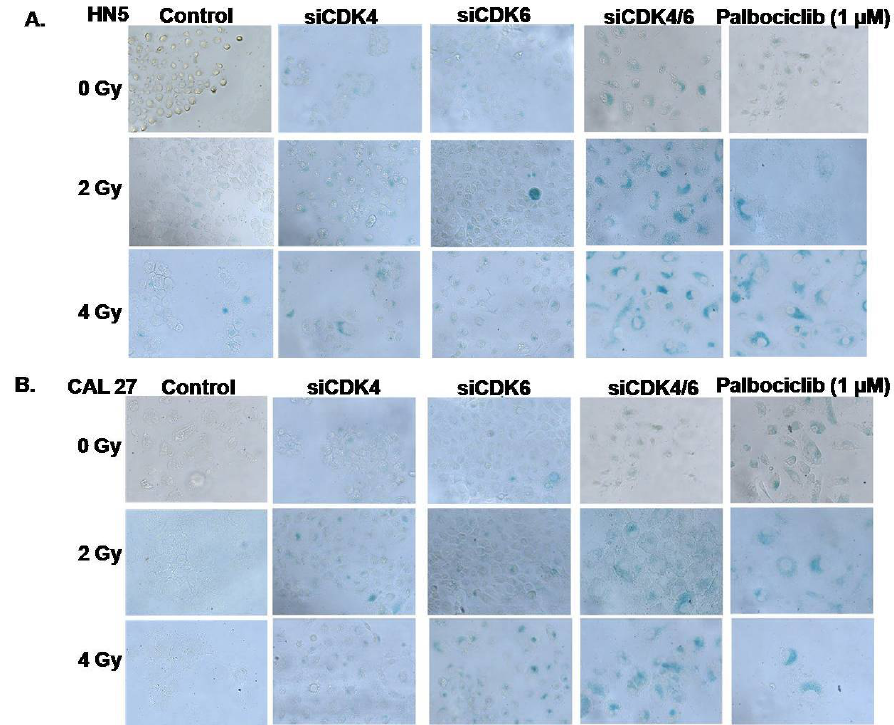
Figure 4. Palbociclib induces senescence in HPV( − ) OCSCC, with levels recapitulated by combined knockdown of CDK4/6 and concurrent radiation treatment. OCSCC cell lines when exposed for 72